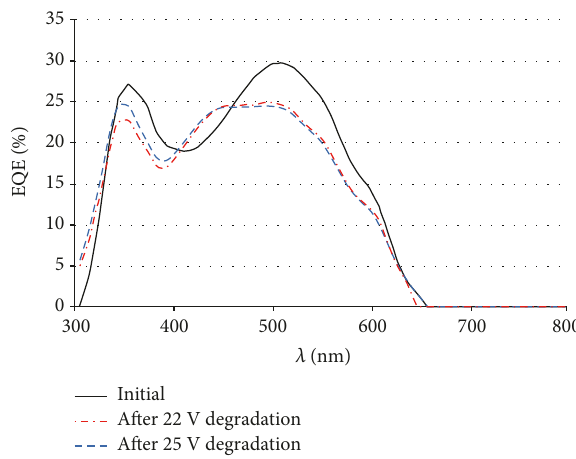
Figure 9: Device 4 fi nger 2 voltage-dependent degradation EQE- λ curve.